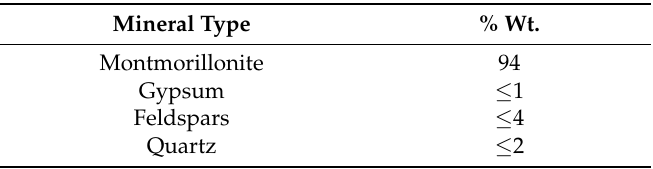
Table 3. Bulk composition of MX-80